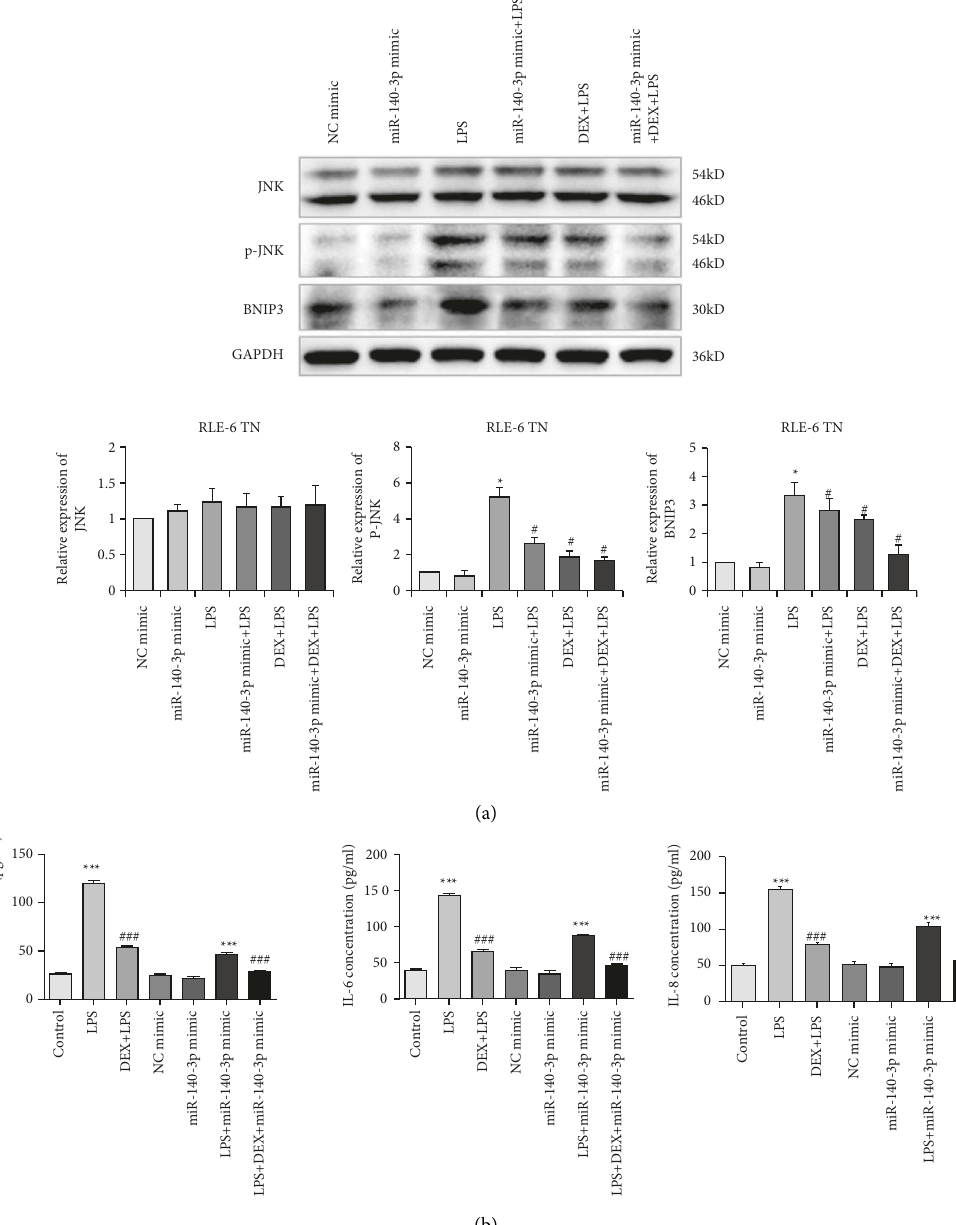
Figure 3: Effects of DEX and miR-140-3p overexpression on JNK-Bnip3 pathway. (a) The relative expression of JNK, p-JNK, and Bnip3. (b) The levels of TNF- α , IL-6, and IL-8 in RLE-6TN cells treated with DEX and miR-140-3p overexpressed. Data are presented as means ± SD ( n � 3; compared to control ∗ p < 0 . 05, compared to LPS-induced # p < 0 . 05, compared to control ∗∗∗ p < 0 . 01, compared to LPS-induced ### p < 0 .